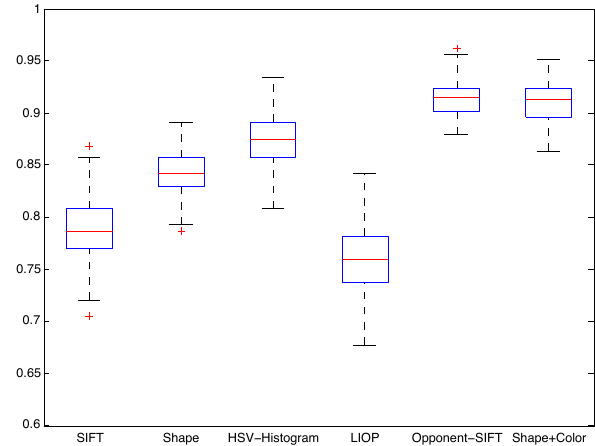
Figure 6: The accurate identifications of microfilariae for 100 runs of the descriptors: Scale-invariant Feature Transform (SIFT), shape histogram (Figure 2), Local Intensity Order Pattern (LIOP), HSV- histogram, Opponent-SIFT, and the proposed multi-classifier ap- proach for both shape and color